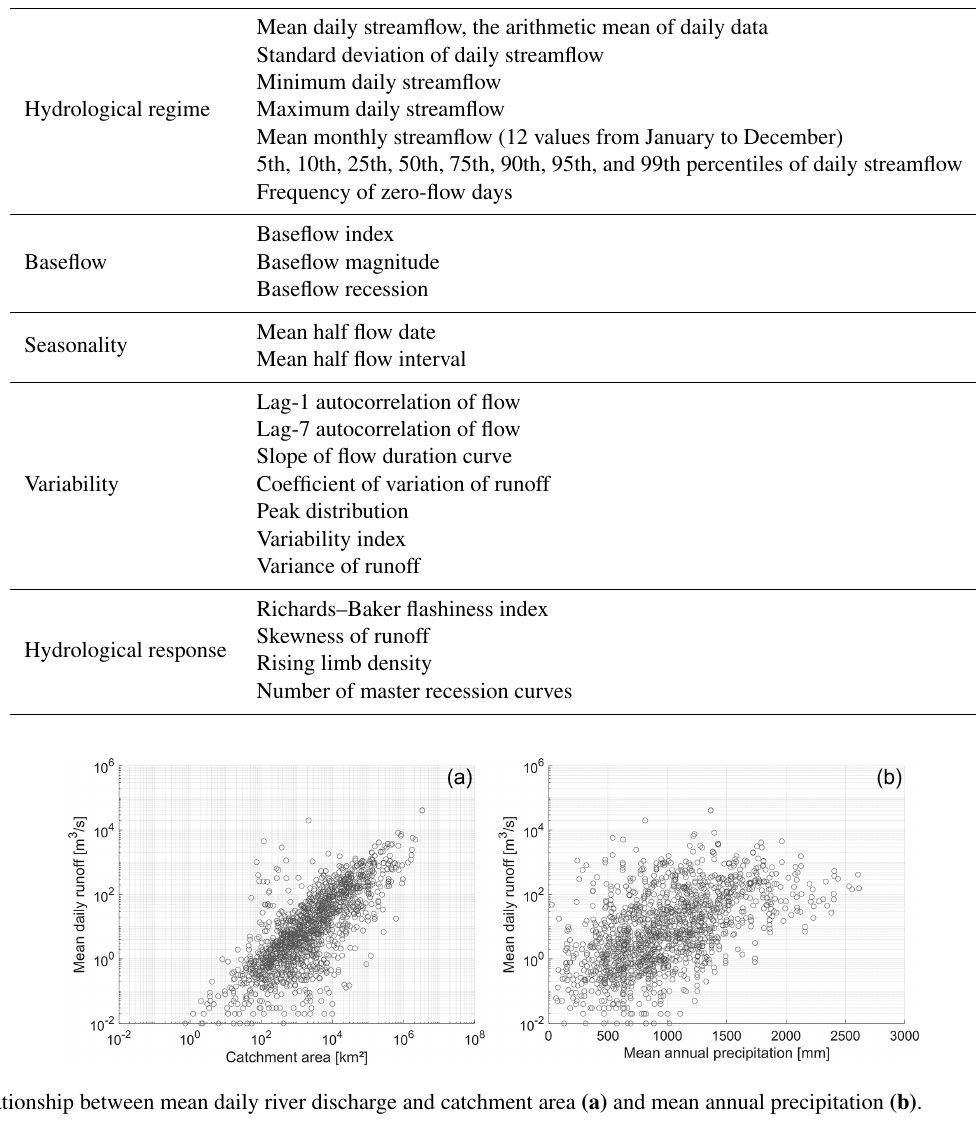
Table 1. Hydrometric indices in the ADHI.